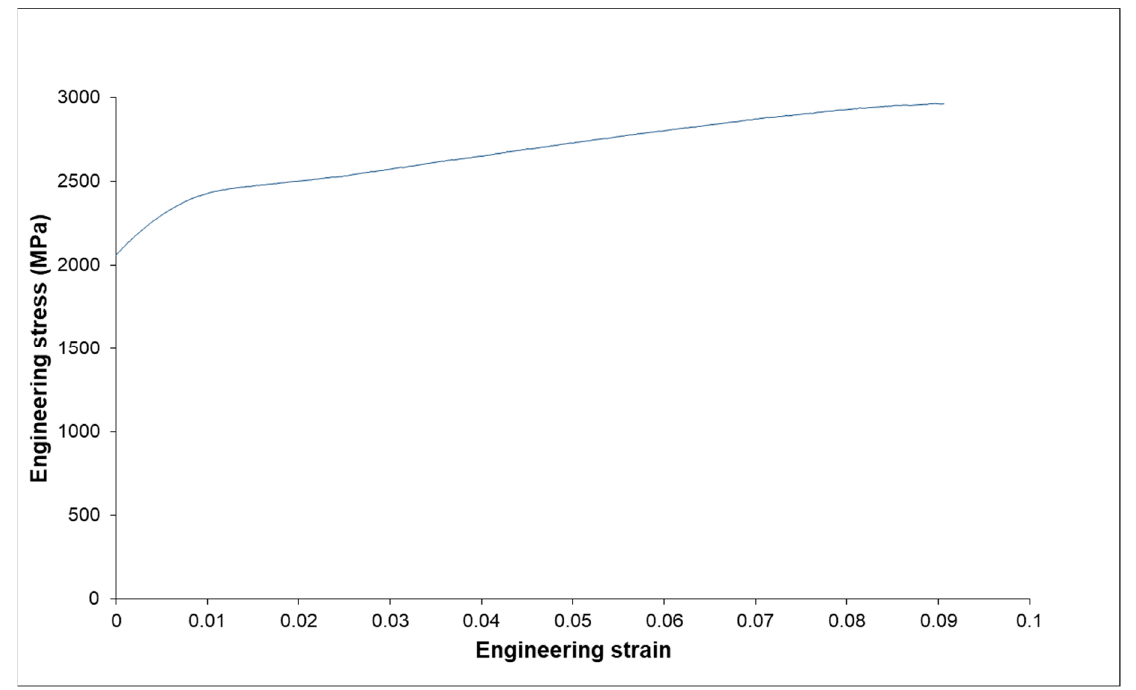
Figure 8. Compression stress strain curve of the sintered sample.